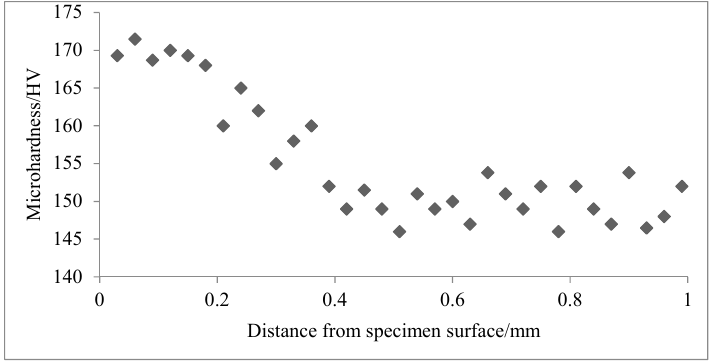
Figure 10. Micro-hardness depth profile of fretting fatigue fractured AlSi9Cu2MgA ( N f = 2.8 × 10 5 , σ n = 62.5 MPa).